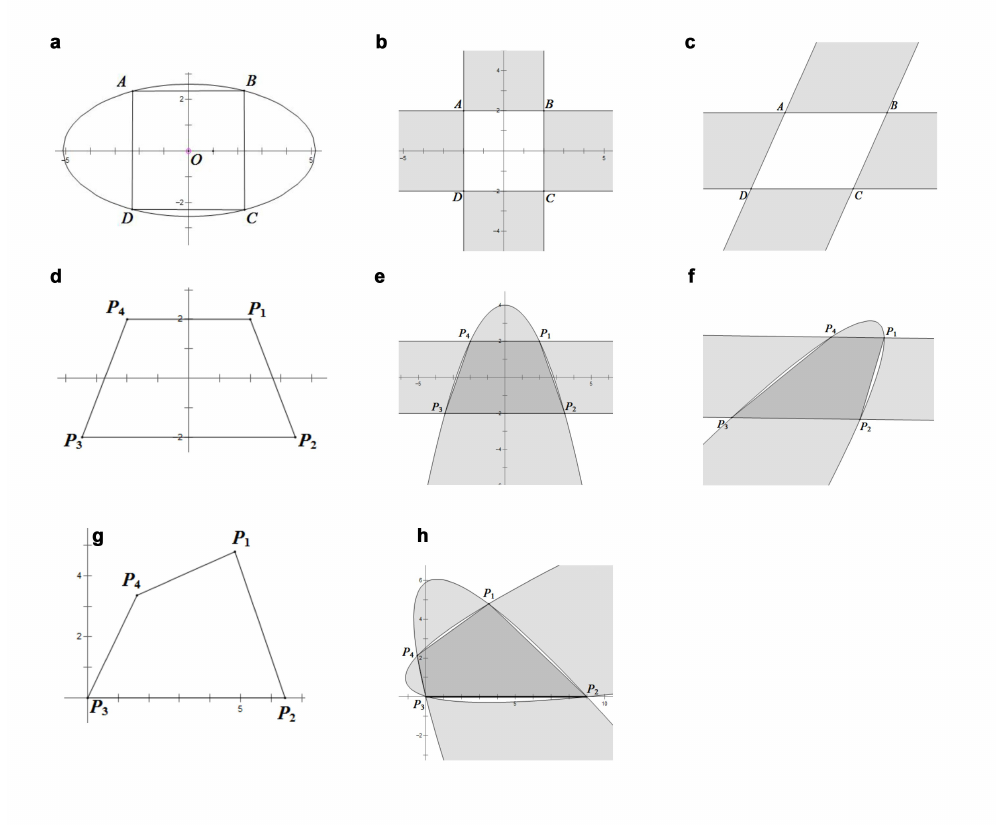
Figure 2: The coverage area of circumscribed ellipses. (a) Set up a rectangular coordinate system for a square. (b) The coverage area of the circumscribed ellipses of a square is the shaded part. (c) The coverage area of the circumscribed ellipses of a paral- lelogram is the shaded part. (d) Set up a rectangular coordinate system for an isosceles trapezium. (e) The coverage area of the circumscribed ellipses of an isosceles trapezium is the light grey part. (f) The coverage area of the circumscribed ellipses of a trapezium is the light grey part. (g) Set up a rectangular coordinate system for a general convex quadrilateral. (h) The coverage area of the circumscribed ellipses of a general convex quadrilateral is the light grey